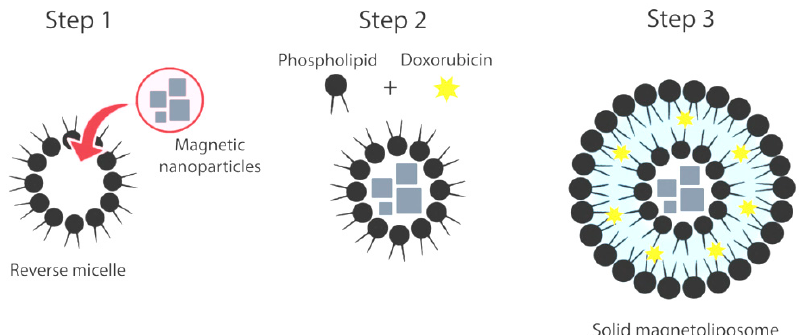
Figure 1. Schematic representation of the synthesis methodology of DOX-loaded solid magnetolip- osomes.